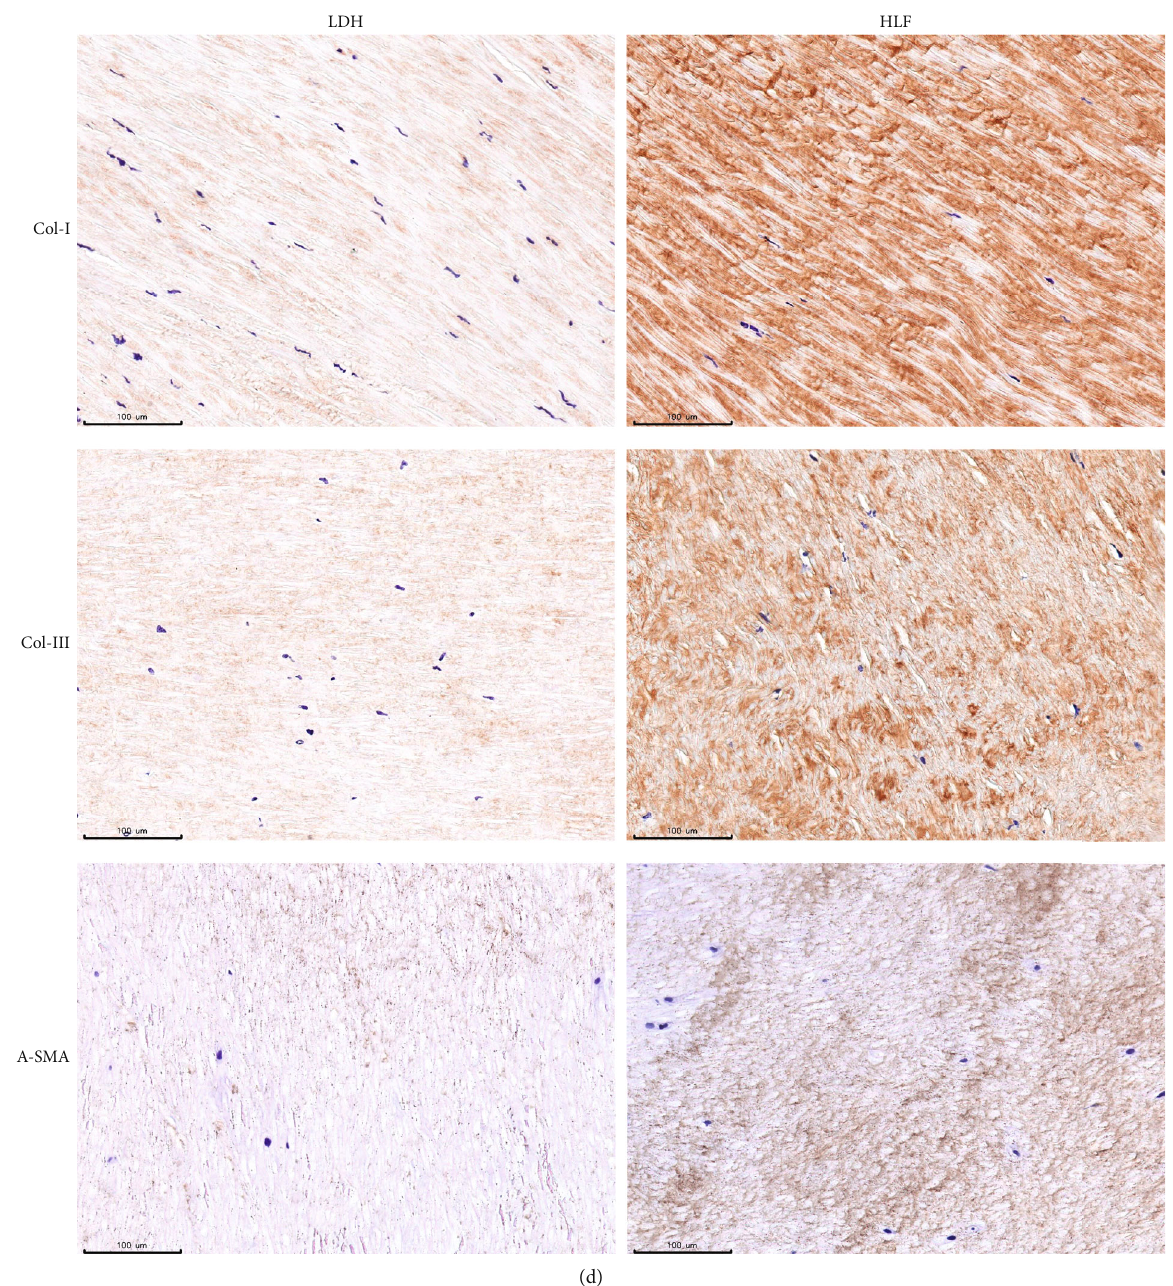
Figure 1: Fibrosis was upregulated in LF tissues from HLF patients. (a) Magnetic resonance imaging (MRI) shows axial views of the lumbar spinal canal in the LDH and HLF patients. (b) Collagen I, Collagen III, and α -SMA mRNA levels in the LDH and HLF patients were assessed by qRT-PCR ( n = 27 ). ∗∗∗ p < 0 : 001 . (c, d) Collagen I, Collagen III, and α -SMA protein expression in the LDH and HLF patients was assessed by western-blot and IHC ( n = 10 ). ∗∗ p < 0 : 01 , ∗∗∗ p < 0 : 001